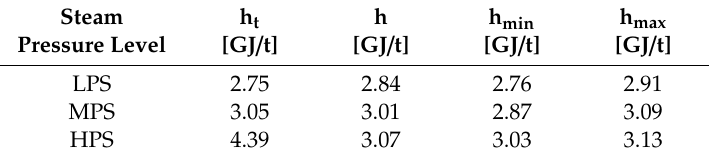
Table 8. Values of theoretical steam enthalpy and typical values of steam enthalpy in the refinery.